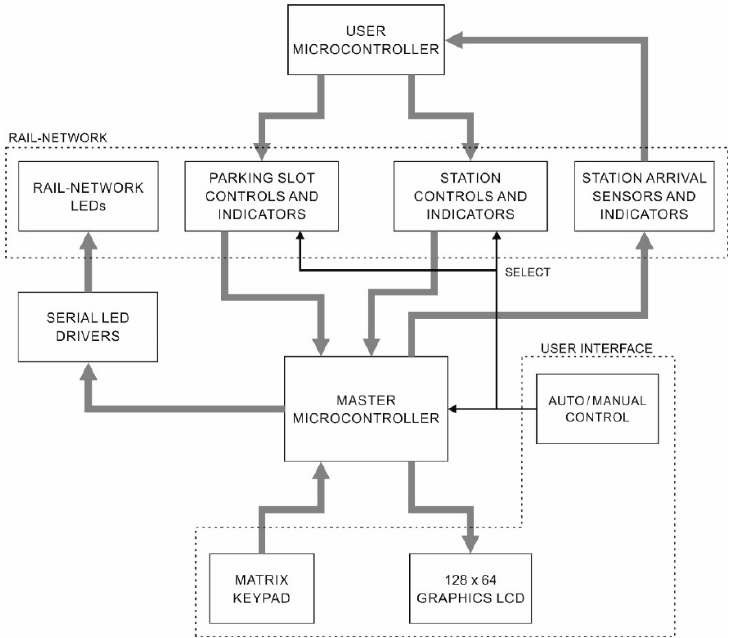
Figure 2. Hardware system architecture of the Rail-Network Simulator.